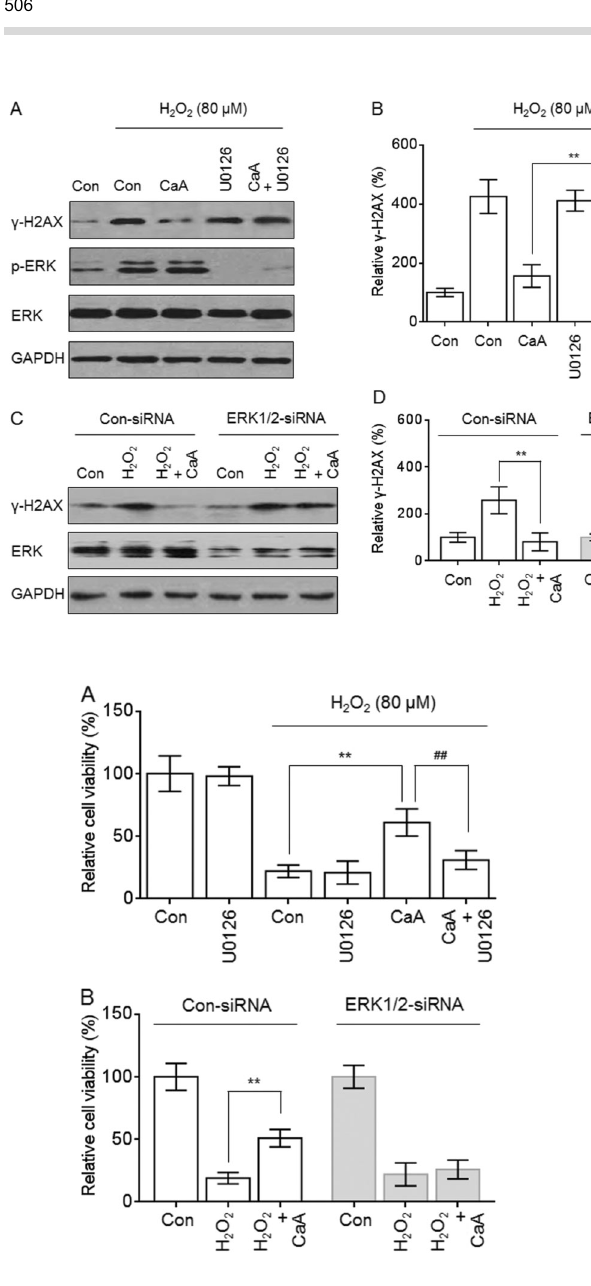
Figure 6. Extracellular signal-regulated kinase (ERK) inhibition blocked the caffeic acid (CaA)-induced improvement of cell viability in H 2 O 2 -treated L-02 cells. A , After pretreatment with 0 or 10 m M CaA in the presence or absence of U0126 (10 m M) for 24 h, they were exposed to 80 m M H 2 O 2 for an additional 24 h. Cell viability was measured by cell counting. Relative cell viability was determined by comparison with control cells. **P , 0.01 compared with L-02 cells treated with H 2 O 2 alone. ## P , 0.01 compared with L-02 cells treated with CaA plus H 2 O 2 . B , After L-02 cells were transfected by 20 nM ERK1 plus ERK2 siRNA for 12 h, they were treated with 0 or 10 m M CaA for 24 h, followed by exposure to 80 m M H 2 O 2 for an additional 24 h. Cell viability was measured by cell counting. **P , 0.01 compared with L-02 cells treated with